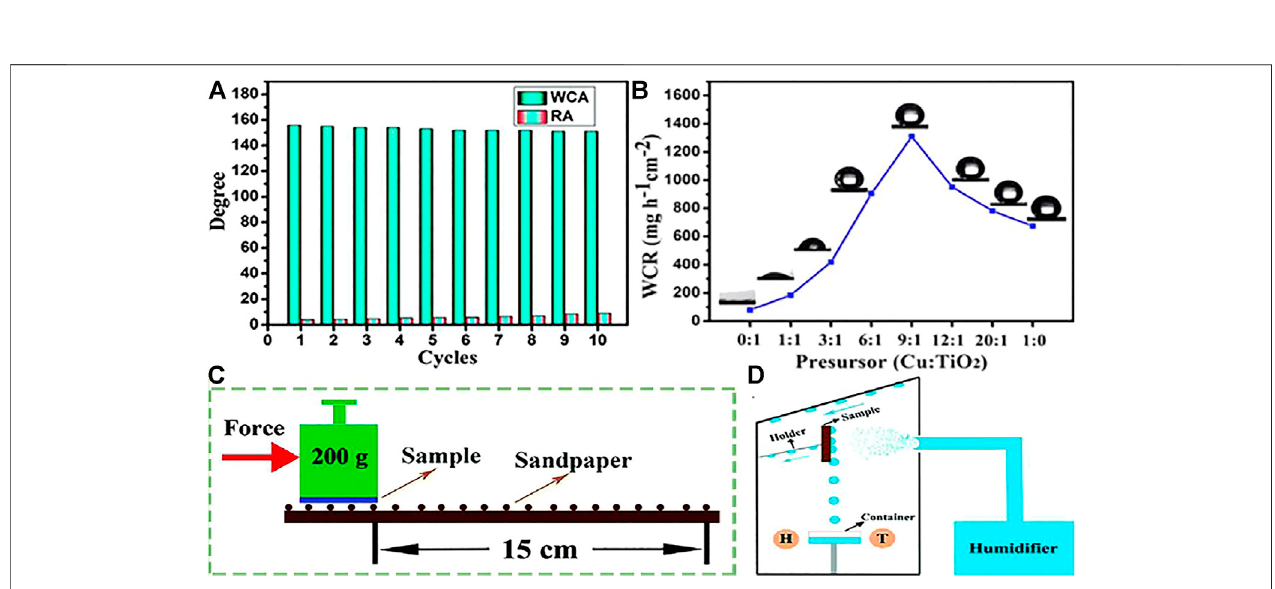
FIGURE13|(A) WCAandRAonthesurfaceafterabrasiontest. (B) WatercollectionratechangedwiththeprecursorofCuandTiO 2 . (C) Schematicoftheabrasion test. (D) Schematic diagram of self-made fog collection system, H and T represent the humidity thermometer (Zhu and Guo,